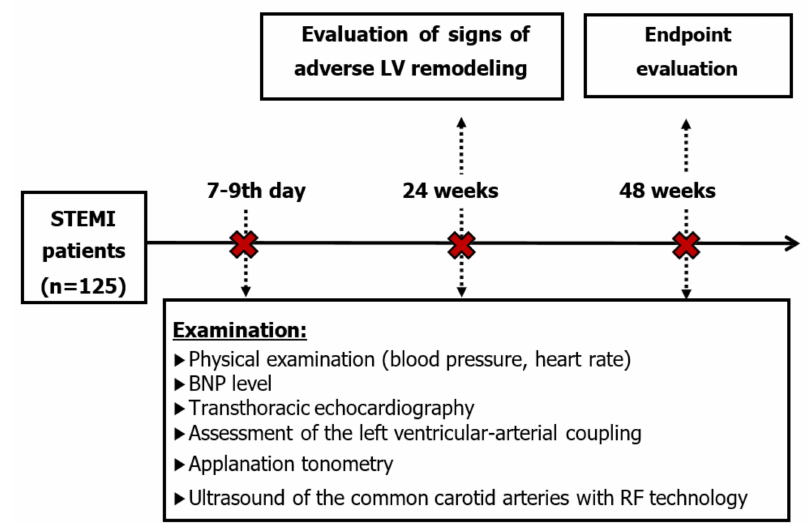
Figure 1. Flowchart of the